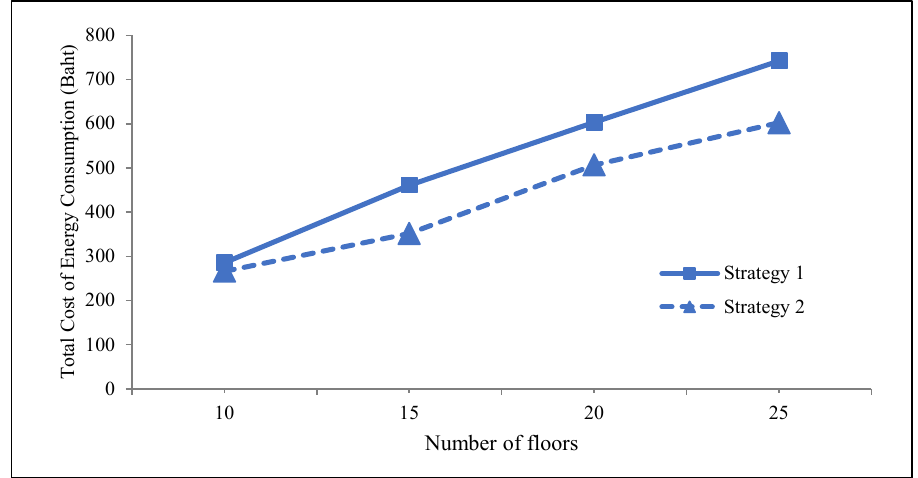
Figure 3. The minimization of the total cost of energy consumption against the number of floors ( 𝐼 = 20 , 𝐽 = 4 , 𝐾 = 10 ). Table 4. Total cost of energy consumption for strategy 1 and 2 in di ff erent problem instances.